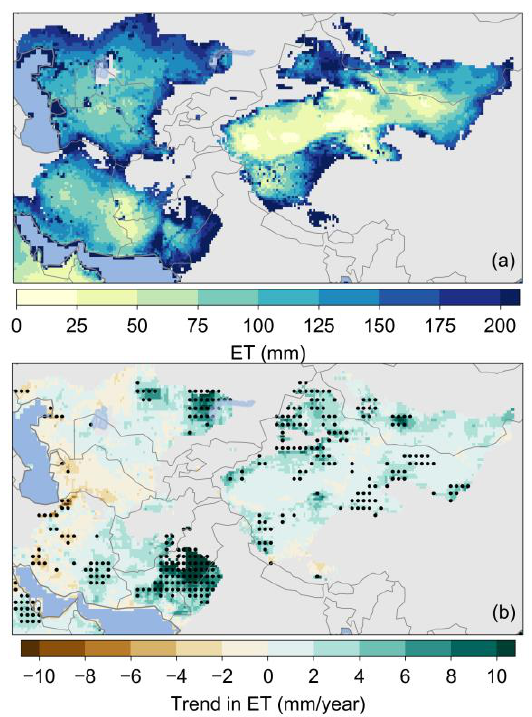
Figure 1. Multi-year mean annual evapotranspiration (ET) and the trend in annual ET from 2003 to 2017. The dotted areas indicate a statistically significant trend.